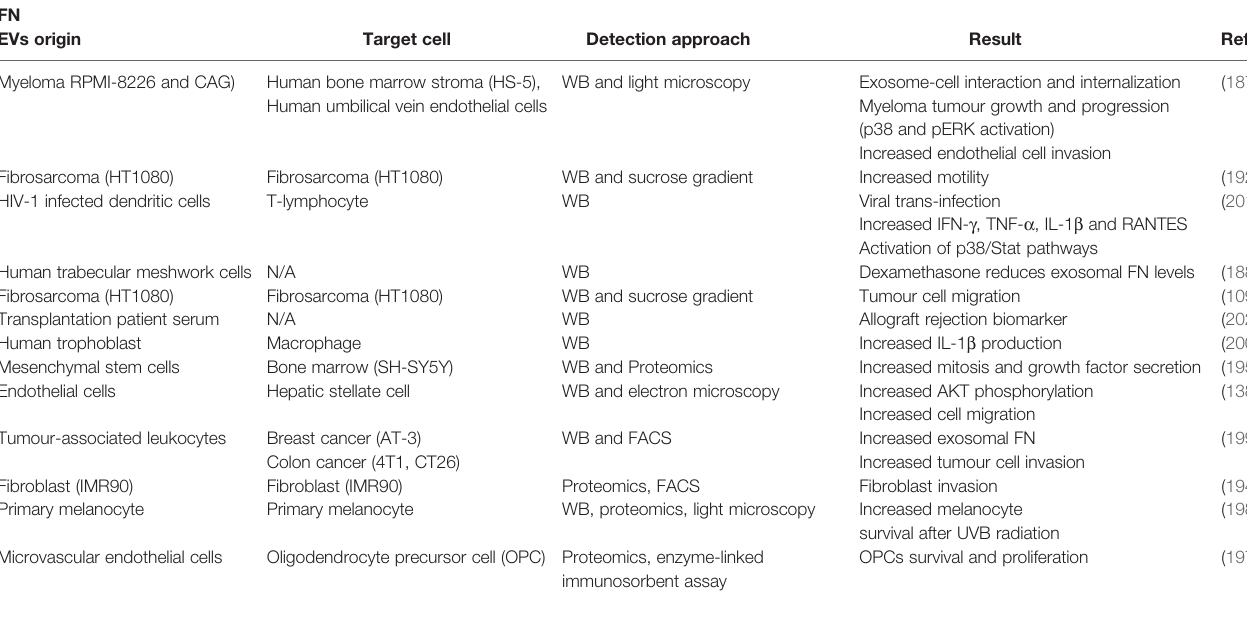
TABLE 1 | Literature contributing evidence of FN as an EV secreted cargo. EVs origin: cell type/tissue from which EVs containing TnC were detected; WB: western blotting. FN EVs